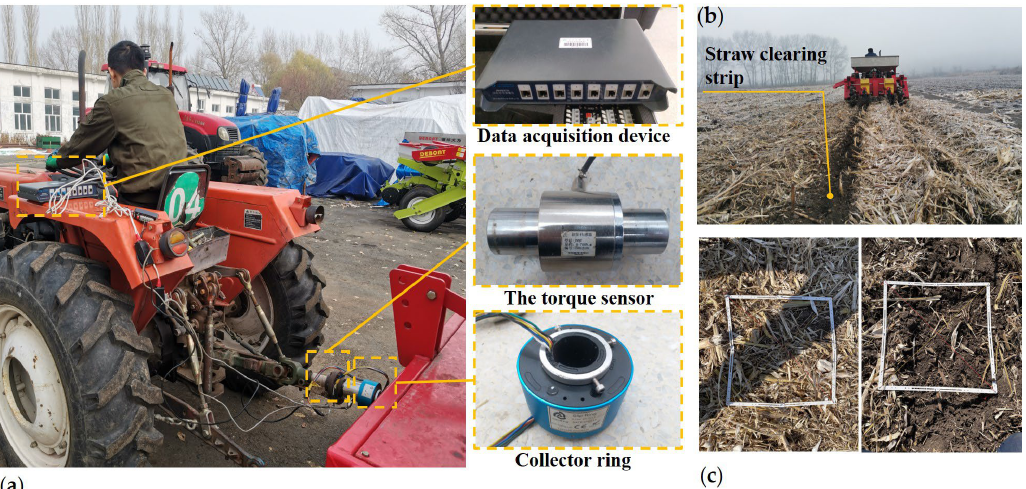
Figure 4. The connection of test instruments and equipment and the measurement of evaluation indexes. ( a ) The connection of power consumption measurement instruments and equipment. ( b ) Test environment and process. ( c ) Straw clearing rate measurement.